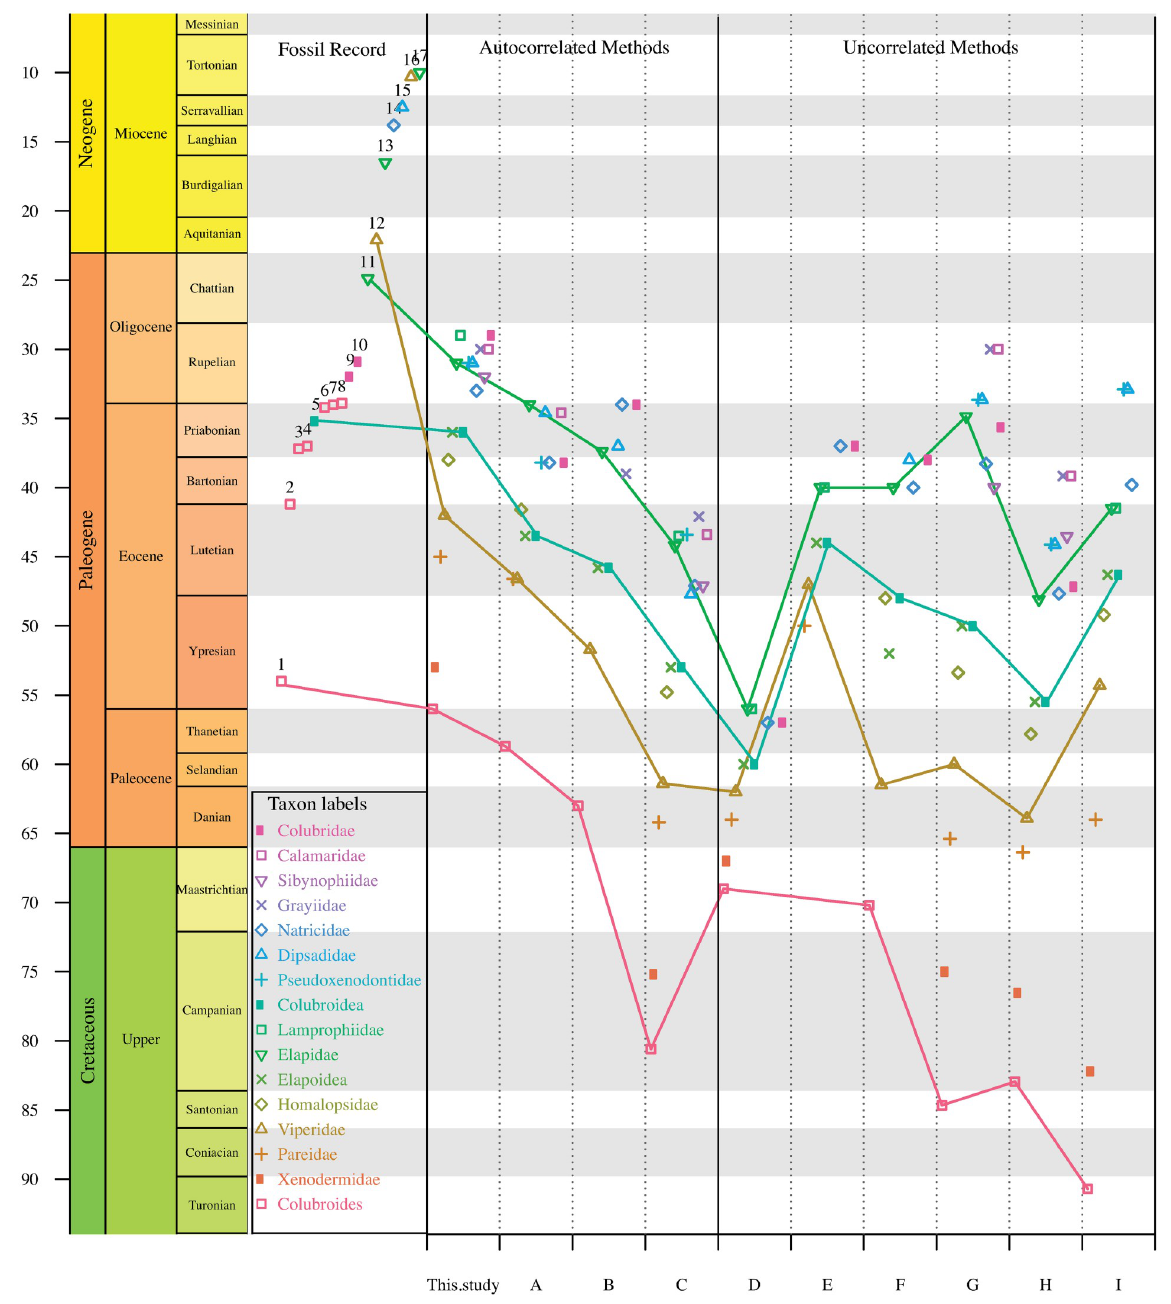
Fig 23. Comparative graph showing divergence time estimations for the main clades of Colubroides in some of the main studies published in the last decade. Numbers near symbols represent the following fossils (see S10 Table for more details): (1) Procerophis sahnii , 54 Mya; (2) Colubroidea Incertae sedis , 41.2 Mya; (3) Colubroidea indet , 37.2 Mya; (4) Renenutet enmerwer , 37 Mya; (5) Colubroidea indet , 35.2 Mya; (6) Nebraskophis sp, 34.2 Mya; (7) Colubrid indet , 34 Mya; (8) Vectophis wardi , 33.9 Mya; (9) Texasophis galbreathi , 32 Mya; (10) Coluber cadurci , 30.9 Mya; (11) Elapidae indet , 24.9 Mya; (12) Vipera cf. V . antiqua , Mya 22.1; (13) Elapidae indet , 16.5 Mya; (14) Natrix longivertebrata , 13.8 Mya; (15) Paleoheterodon tiheni , 12.5 Mya; (16) Sistrurus sp., 10.3 Mya; (17) Incongruelaps iteratus , 10 Mya. Letters represent the following contributions: (A) Burbrink and Pyron [132]; (B) Kelly et al. [22]; (C) Zheng and Wiens [26]; (D) Hsiang et al. (58); (E) Hsiang et al. (58); (F) Wuster et al. [133]; (G) Pyron and Burbrink [134]; (H) Alencar et al. [124]; (I) Vidal et al. [135].